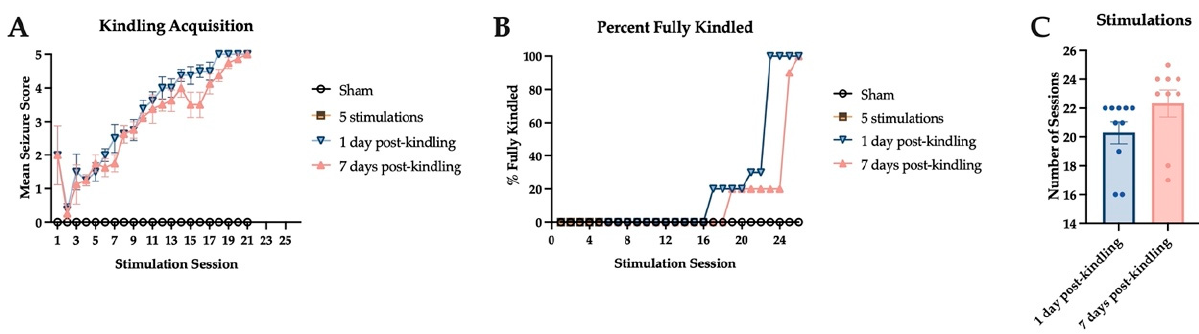
Figure 2. The acquisition of the fully kindled state was no different between the experimental groups used for assessment of H 2 S levels in isolated mouse brains during or after the corneal kindling procedure. Male CF-1 mice were electrically kindled twice daily with a 3.0 mA 60 Hz electrical stimulus delivered bilaterally to anesthetized corneas; sham-kindled mice were similarly handled, but no stimulation was delivered. ( A ) The mean seizure score of mice (+/ − S.E.M.) that were euthanized 1 day after attaining the fully kindled state was not different from mice that were euthanized 7 days after reaching the kindling criterion. ( B ) The percent of fully kindled mice in each stimulation cohort was not significantly different. ( C ) There was no significant difference between the two fully kindled cohorts in the numbers of stimulation sessions needed to reach kindling criterion (mean +/ − S.E.M.).